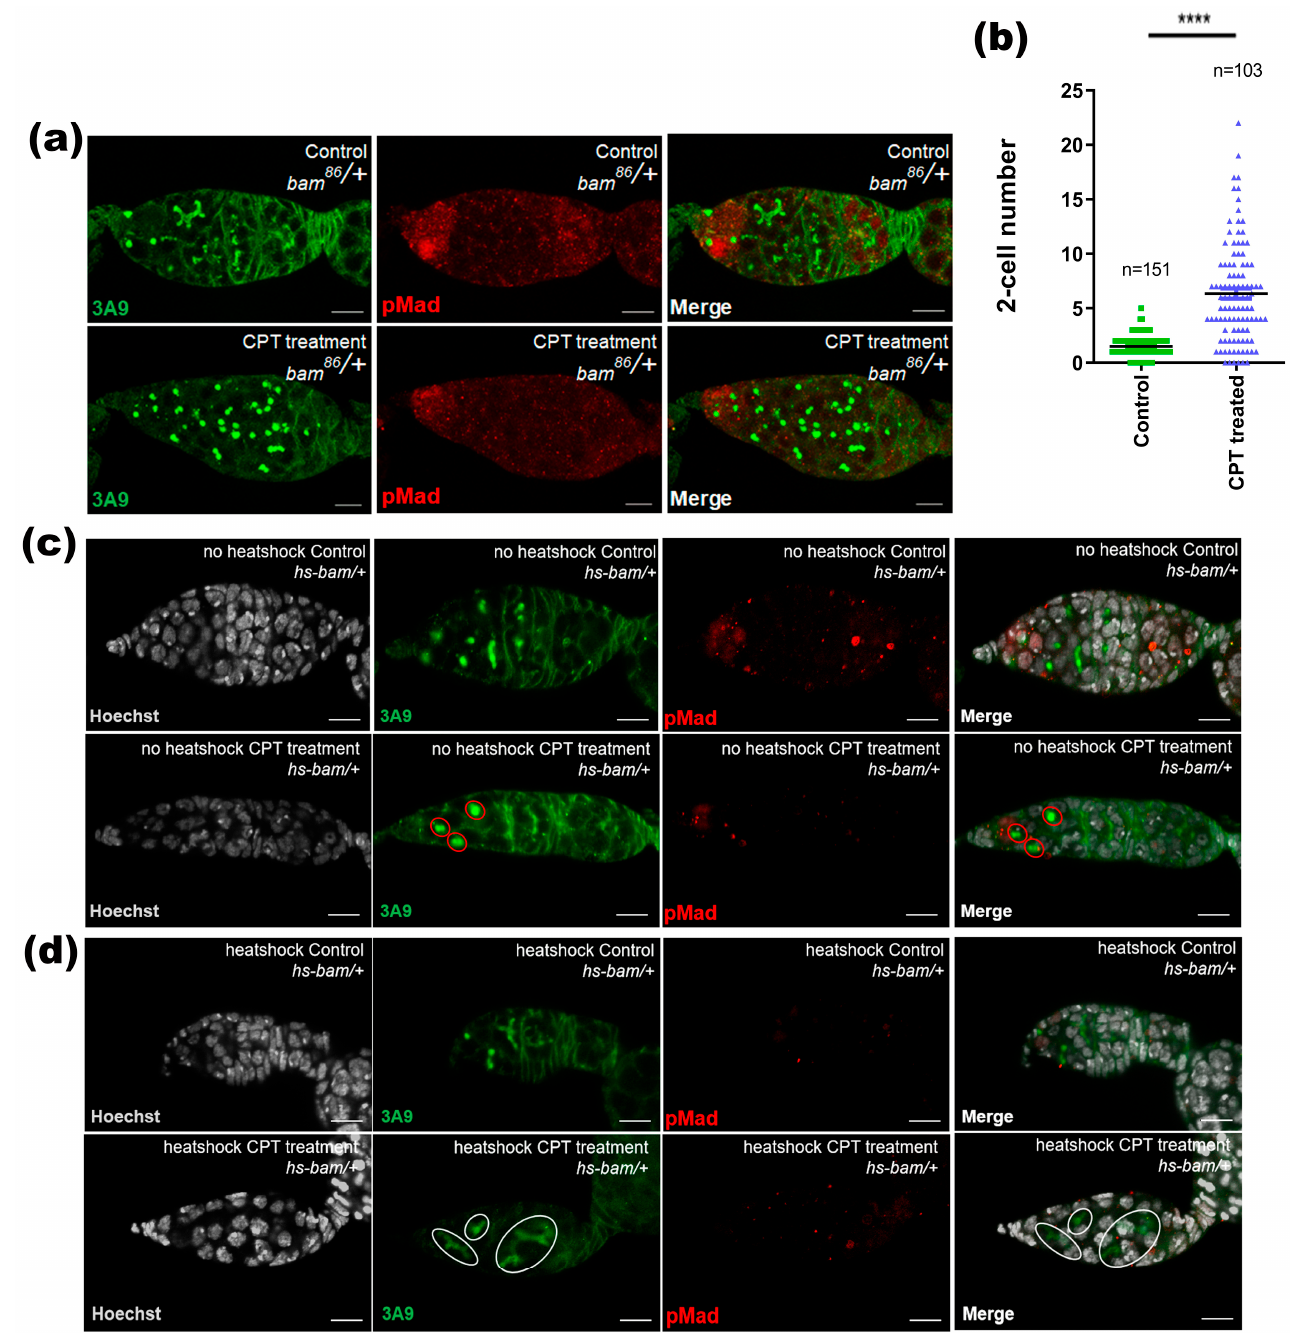
Figure 4. Bam can significantly rescue the two-cell accumulation caused by CPT. ( a ) bam 86 with anti-pMad (red) and anti-3A9 (green) staining with or without CPT treatment. ( b ) Data summarized the number of two-cell cysts in ( a ), green indicated control, blue indicated CPT treatment. ( c , d ) Control and CPT-treated female flies with or without exposure to heat shock to drive bam expression and staining with anti-pMad (red) and anti-3A9 (green). Statistical comparisons were based on Students’ s t -tests. The level of significance for the results was set at **** p < 0.0001. Scale bar, 10 μ m.